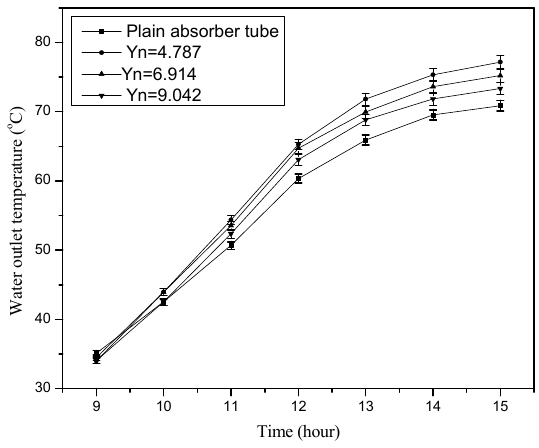
Figure 7. Variation in water outlet temperature with time and nail twist pitch ratio.